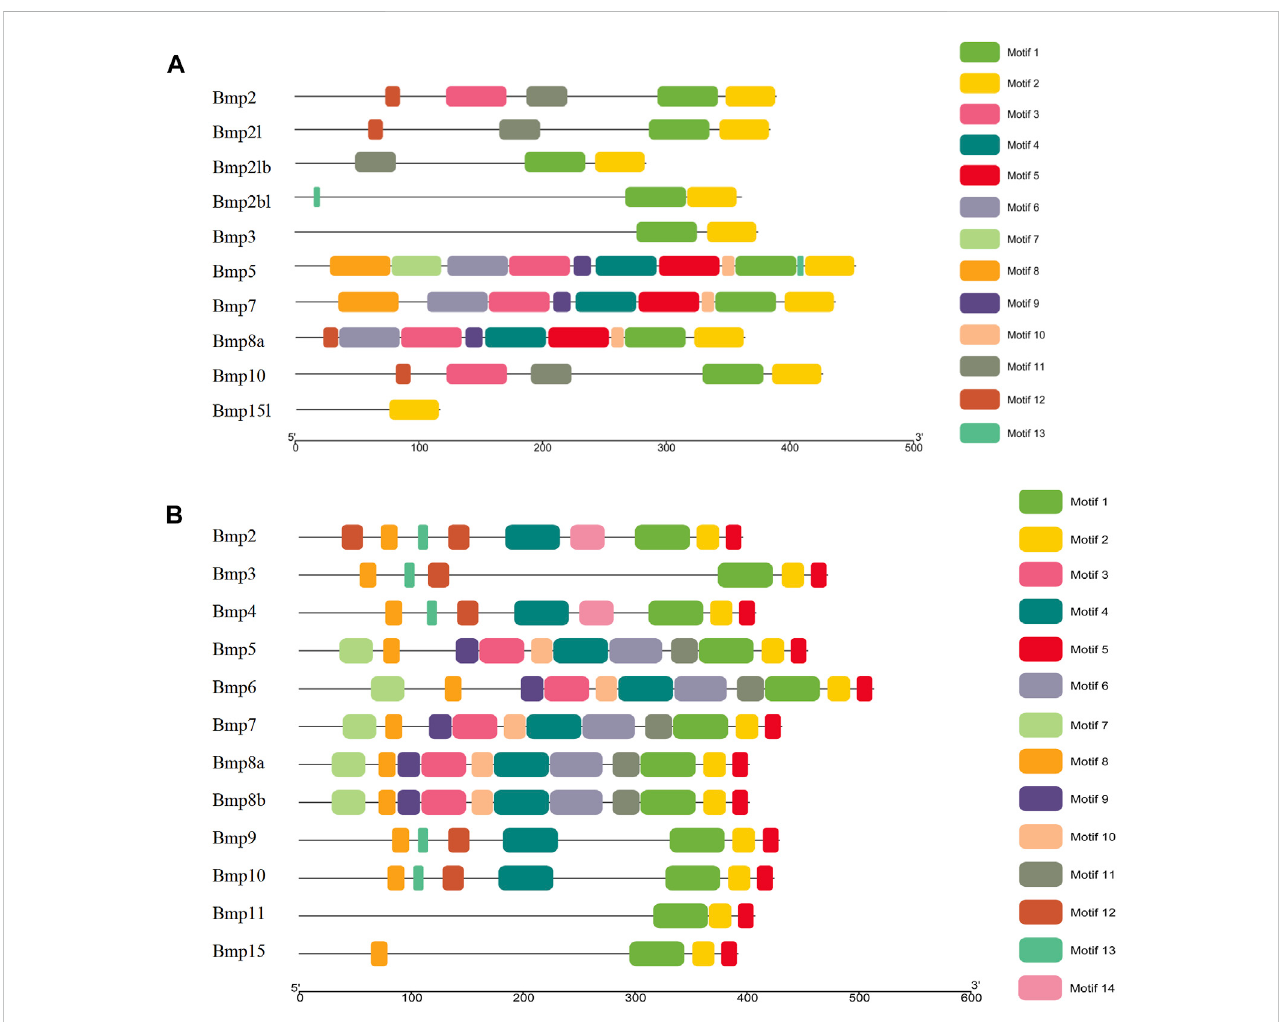
FIGURE 5 ConservedmotifsofBMPgenesin P . sinensis (A) and Homo (B) .Differentcoloredboxesindicatedifferentmotifs;thedirectionoftheproteinsisfromthe N-terminal to the